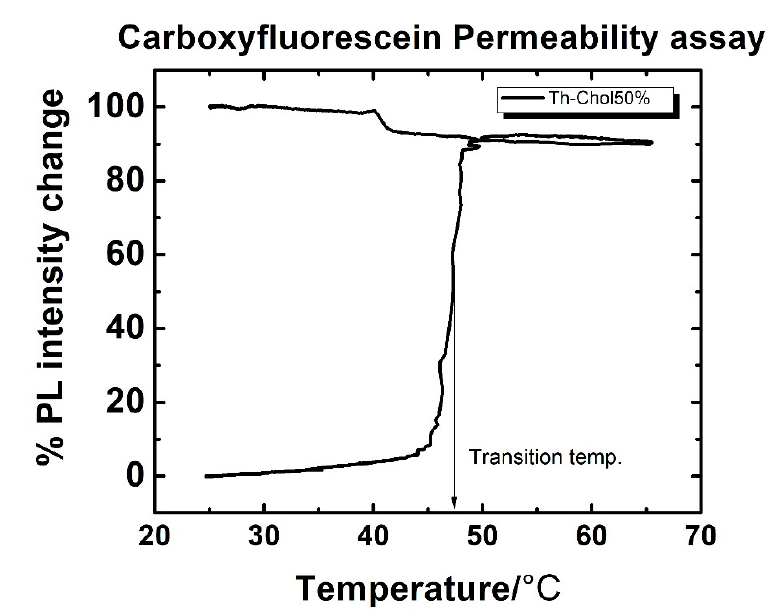
Figure 8. Typical PL curve of the liposomes loaded with CF. The PL slowly increases with temperature as the CF starts leaking out from the liposomes. When the temperature reaches the transition temperature of the liposomes, it releases its load. When the heated sample undergoes cooling, the PL will gradually increase till room temperature reached again. The initial and final PL provide the measuring stick for the amount of drug released from the